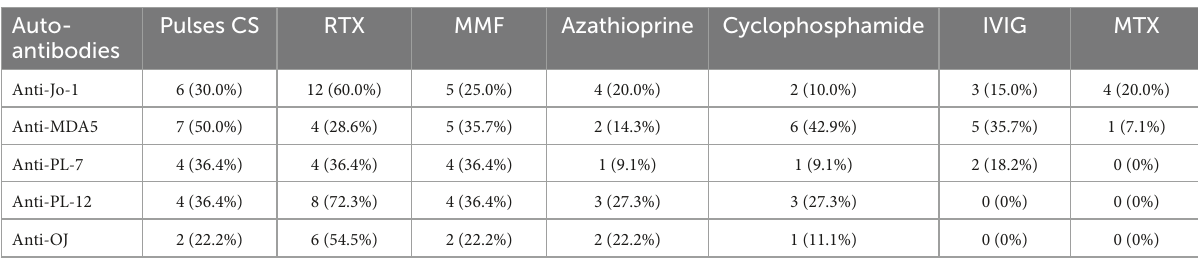
TABLE 4 Most common treatment regimens per myositis